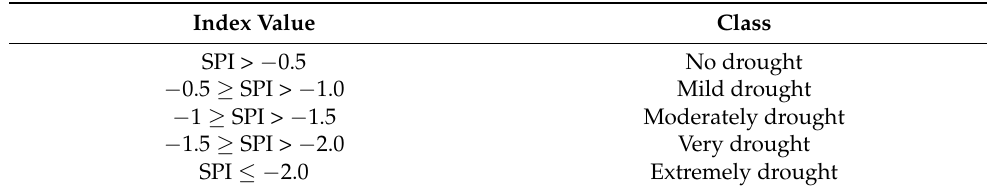
Table 1. Wet and drought period classification according to the SPI